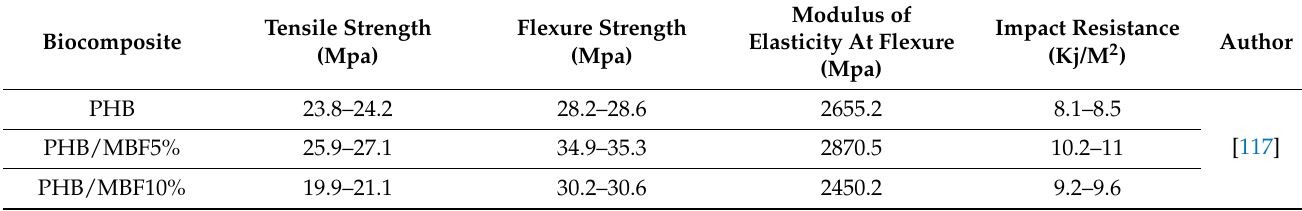
Table 9. Mechanical properties of PHB-based